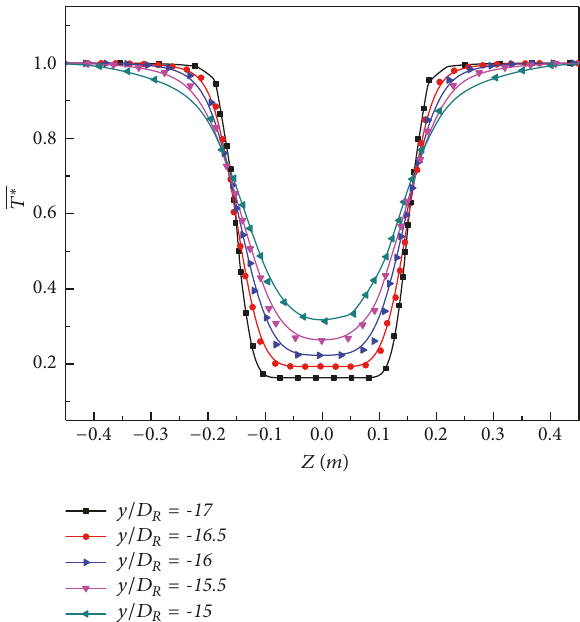
Figure 15: Dimensionless time-averaged velocity of different points in center plane.